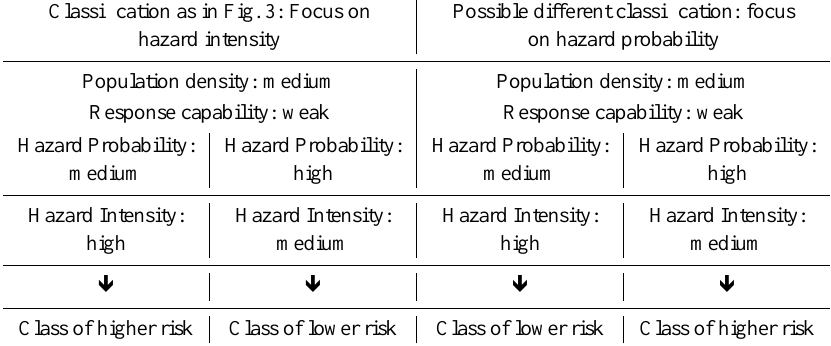
Table 3. Potential classifications of risk. Classification as in Fig. 3: Focus on Table 3: Potential classifications of risk Table 3: Potential classifications of risk Table 3: Potential classifications of risk Table 3: Potential classifications of risk Classification as in Fig. 3: Focus on Classification as in Fig. 3: Focus on Classification as in Fig. 3: Focus on Classification as in Fig. 3: Focus on hazard intensity hazard intensity hazard intensity hazard